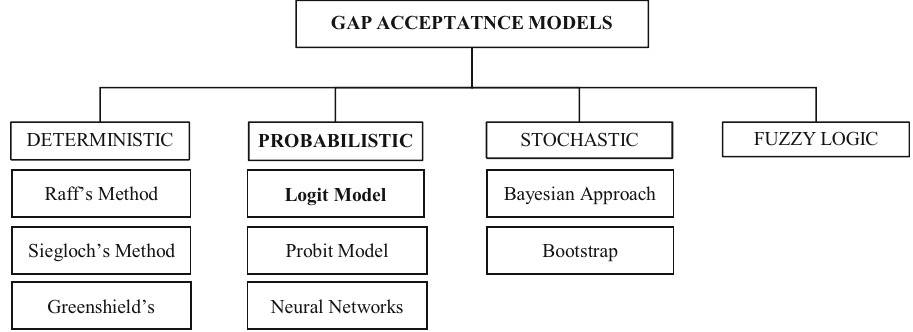
Fig. 3 Classification of various approaches for gap acceptance